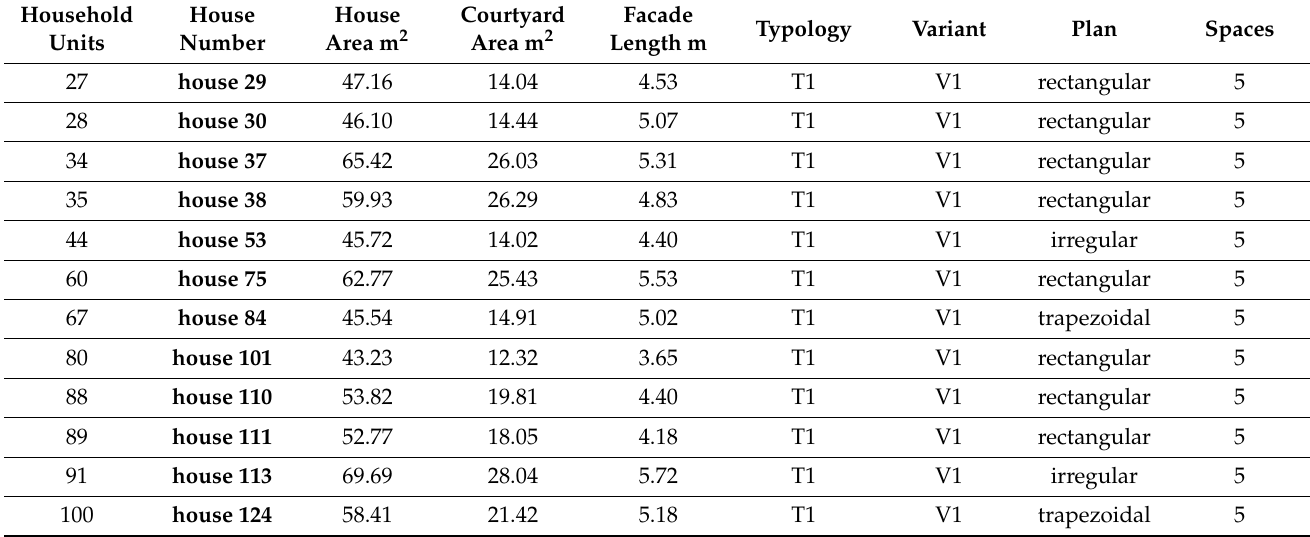
Figure 6. House 103. Room E3 with remains of charcoal.